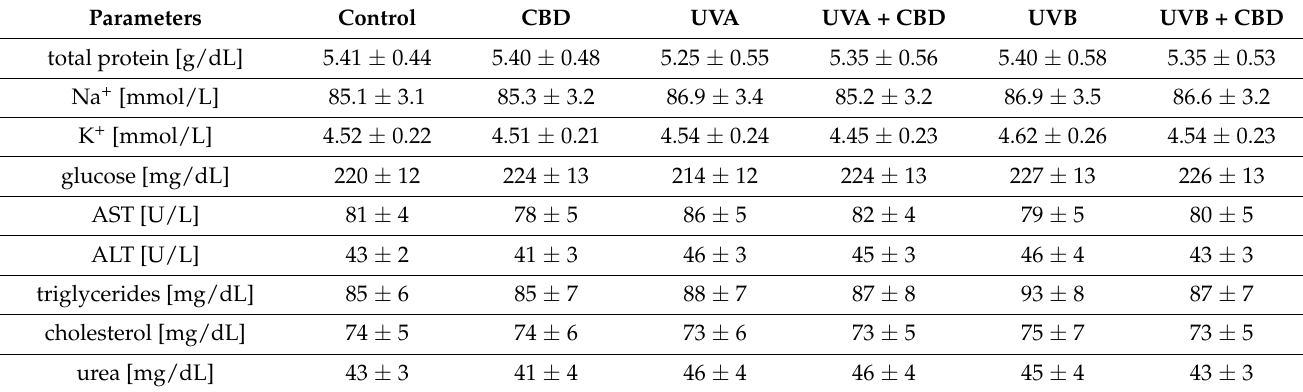
Table 1. Biochemical parameters in plasma of rats which skin was irradiated with UV and treated with CBD. Parameters Control CBD UVA UVA +